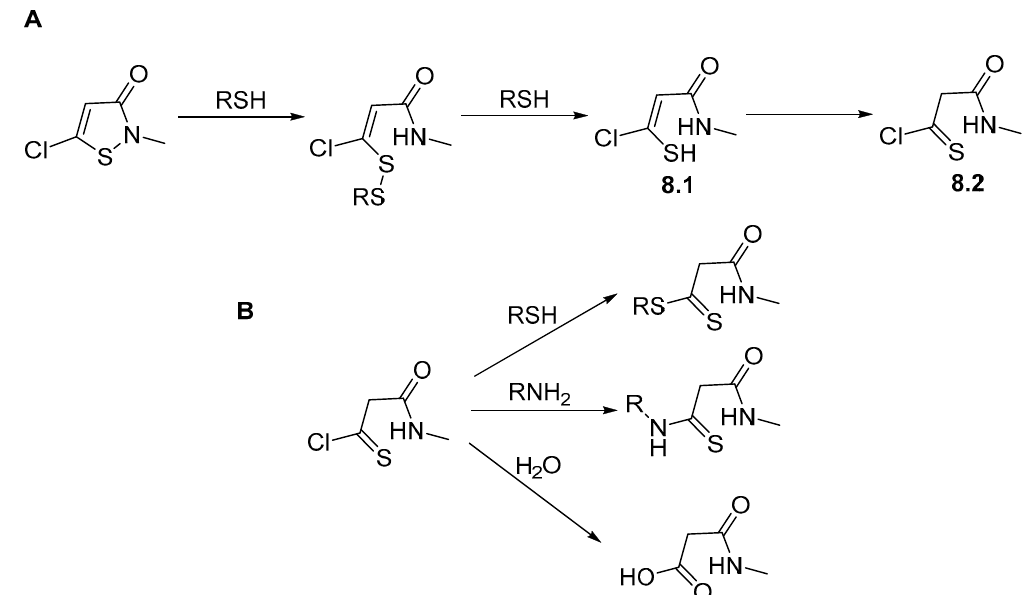
Scheme 8. Reaction pathway of MCI. ( A ) Interaction with thiols from cellular components (e.g., GSH)